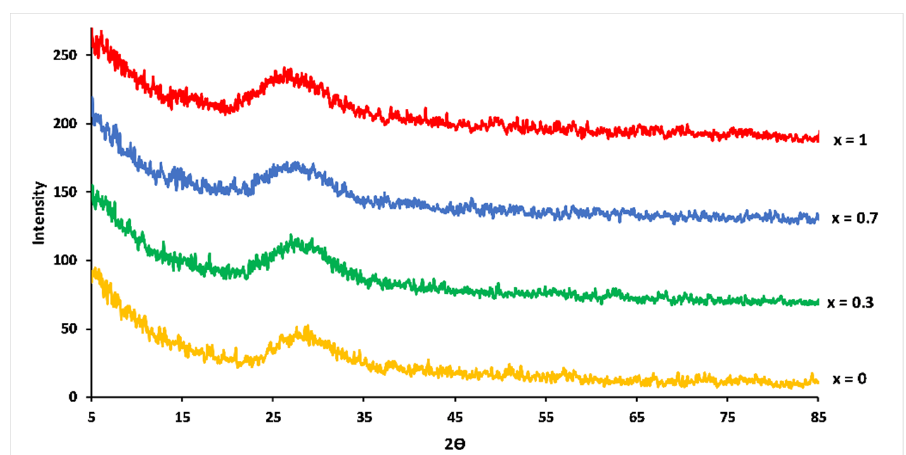
Figure 2. XRD patterns for 3P 2 O 5 -2K 2 O-(1 − x)CaO-xMgO glasses.